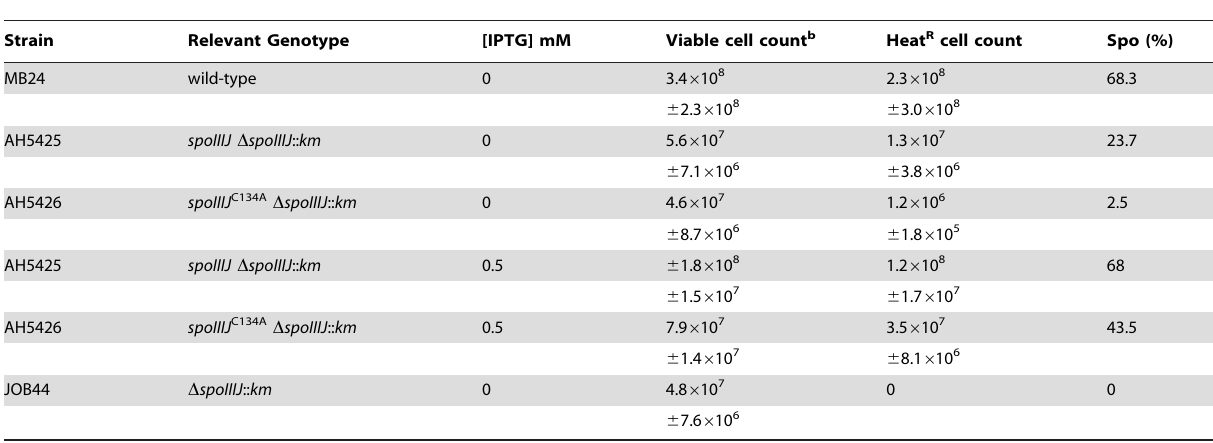
Table 1. Efficiency of sporulation a of strains bearing various spoIIIJ alleles.